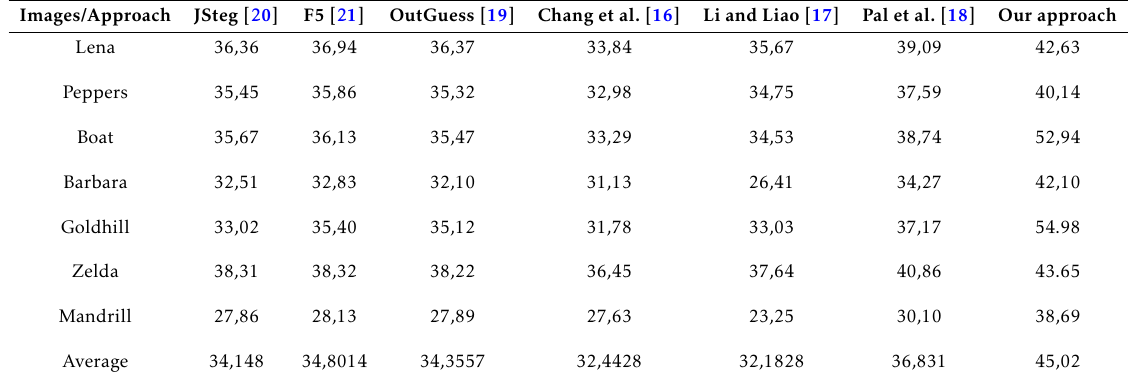
Table 2: Our approach vs. similar works in terms of PSNR